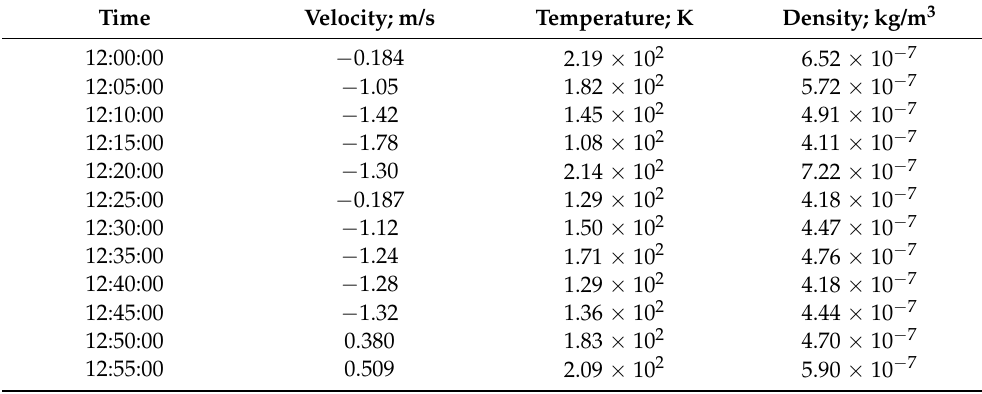
Table 1. Experimental data take the form of measurements of temperature, density, and vertical gas